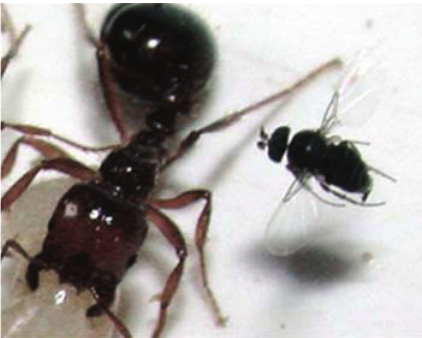
Figure 7: Pseudacteon fly chasing a Solenopsis invicta worker for oviposition (photo by S. D.